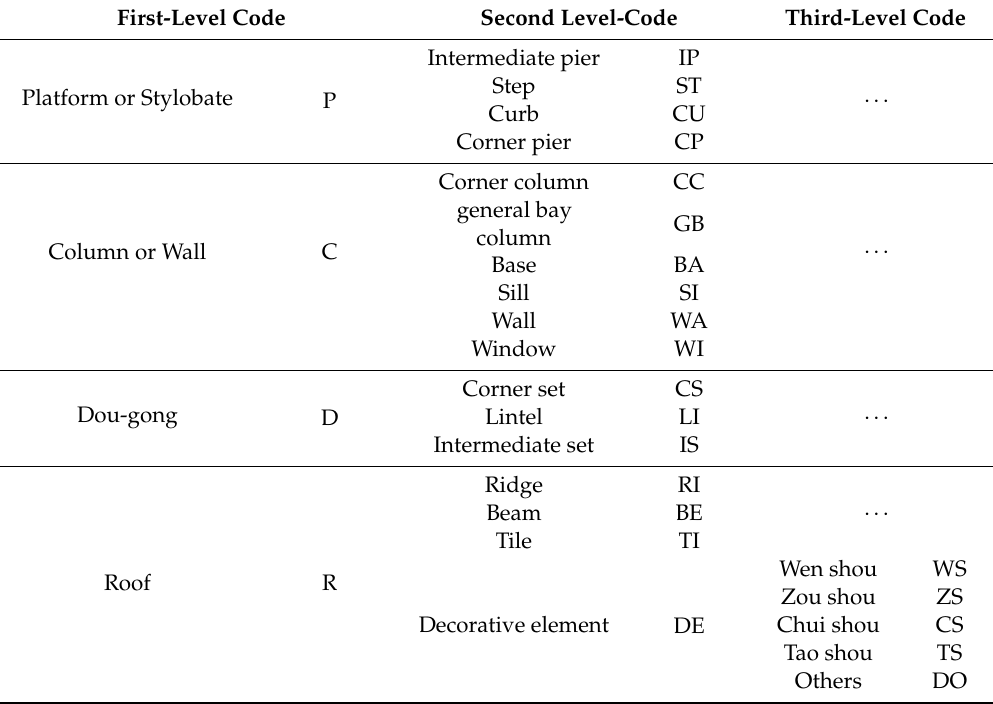
Table 5. Design of flexible